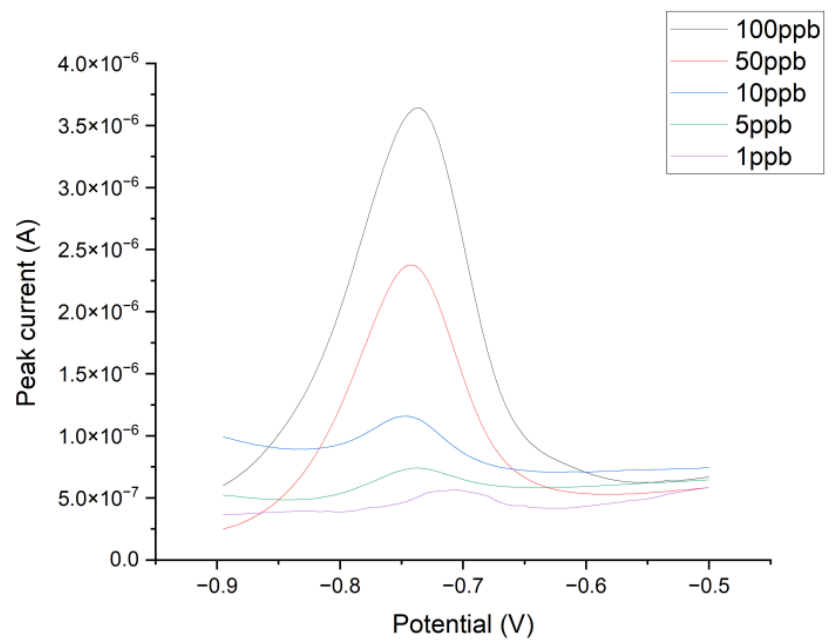
Figure 9. Anodic stripping voltammograms of 1 µg/L to 100 µg/L Pb(II) in 10 mM KNO 3 detected by commercial sensor with modified Nafion.